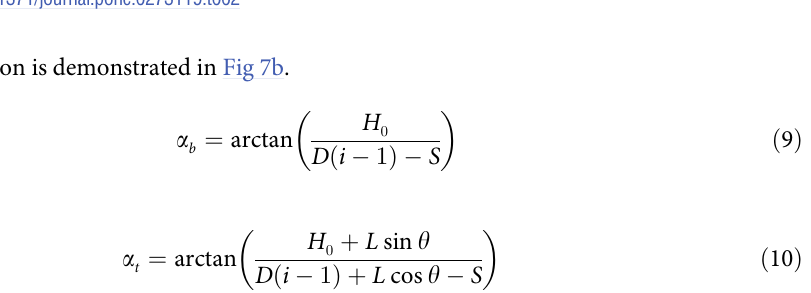
< ϕ , and α > ω . t b > ϕ , and α < ω t b